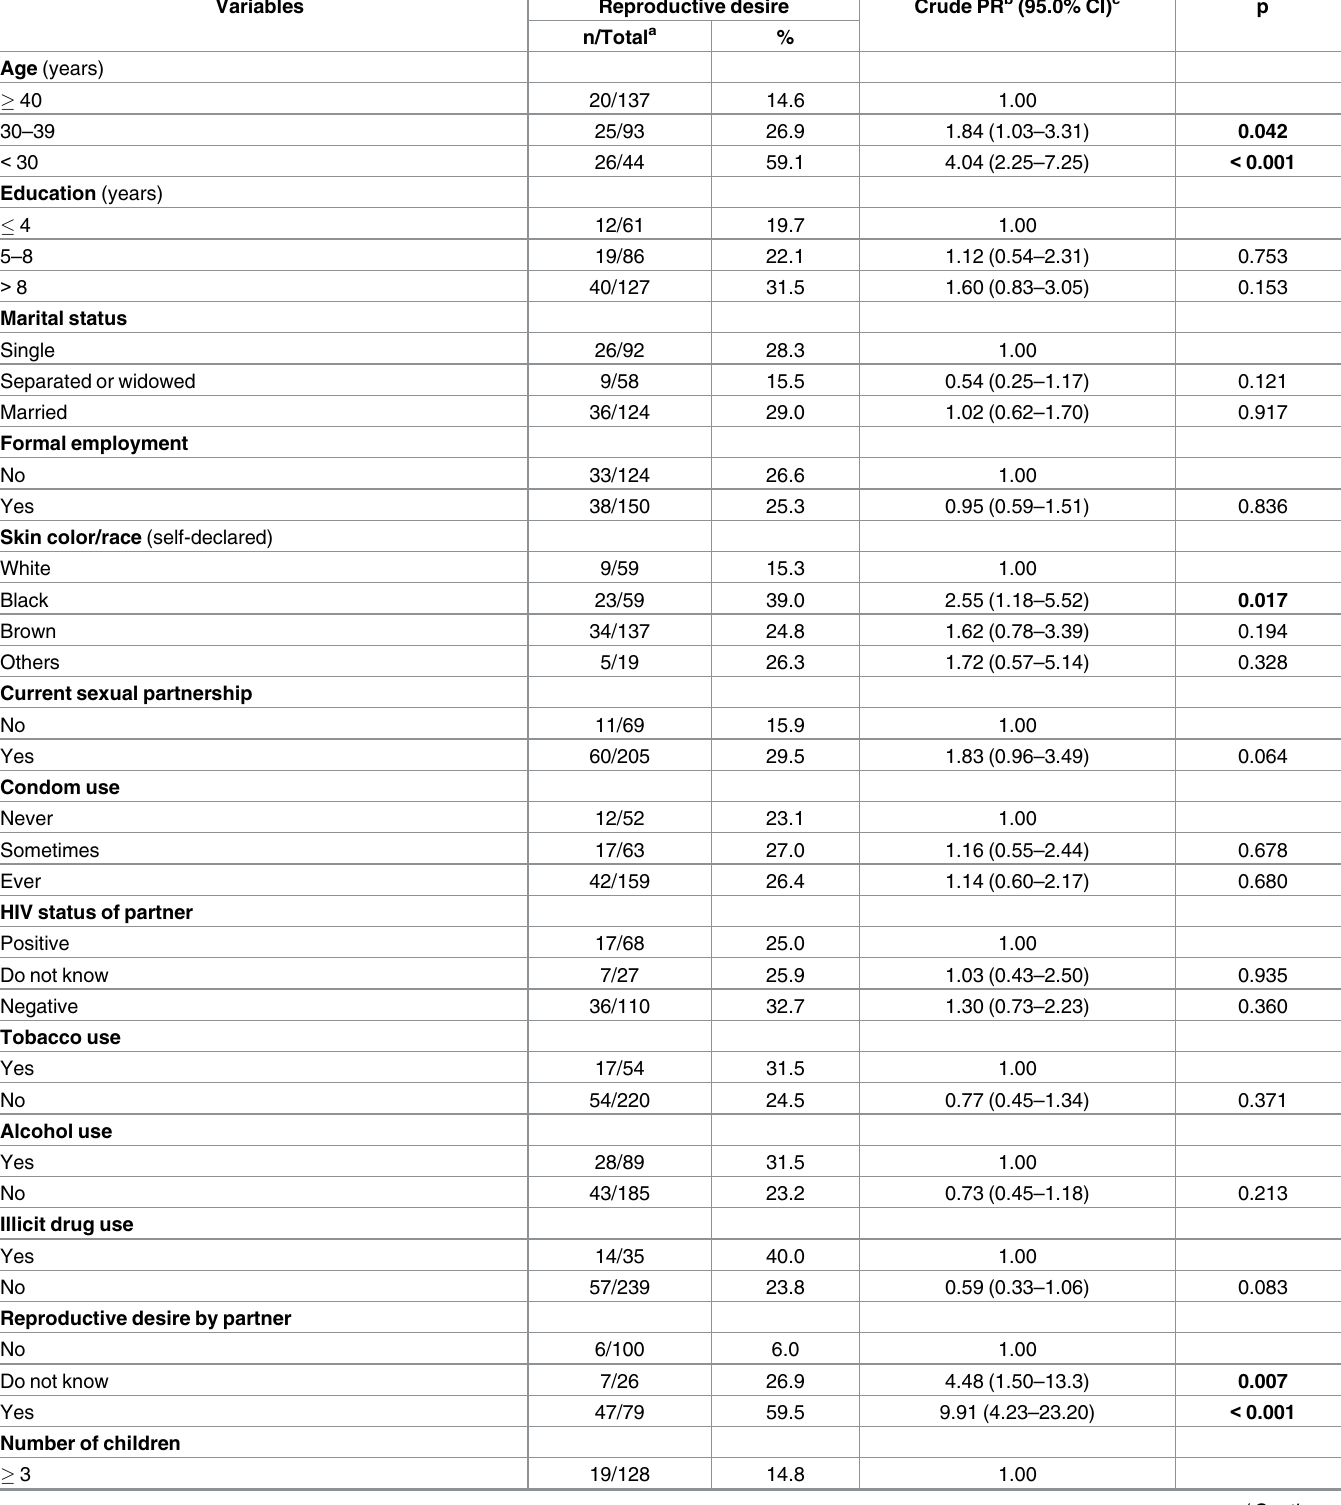
Table 4. Potential factors associated with reproductive desire in WLWHA in Central Brazil,